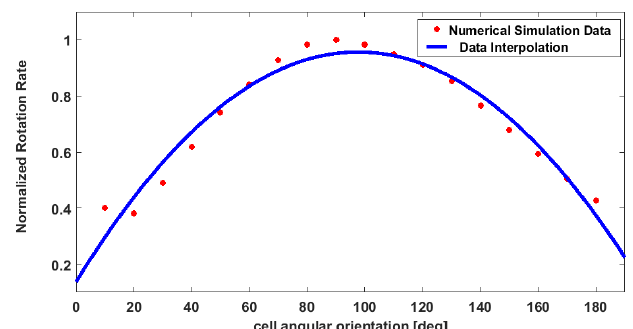
Figure 5. Numerical simulation data. Normalized rotation rate for an ellipse at different angular position respects to the fluid flow direction. The 0° refers to the ellipse in a horizontal position, with the major axis parallel to the fluid flow direction. As expected, when it is in this position, the rotation rate is low, and it increases when it gets close to the vertical position, with the major axis perpendicular to the fluid flow direction.